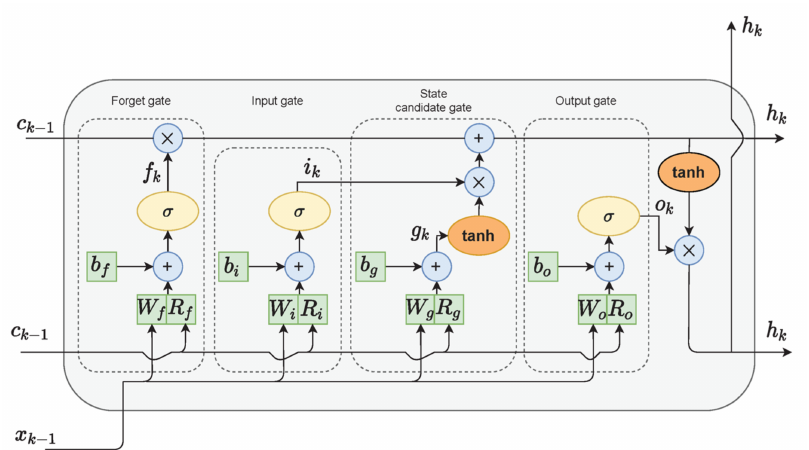
Figure 3. LSTM cell diagram. Adapted from Zarzycky and Ławry´nczuk (2021)